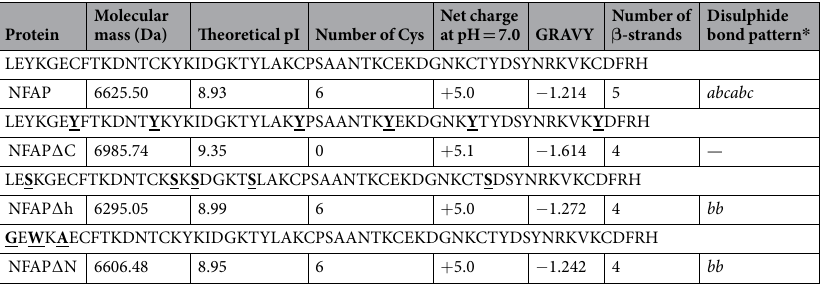
Table 1. Amino acid sequence and in silico predicted physical and chemical properties of the mature NFAP and its mutants. Substitutions in the amino acid sequences are indicated with bold and underlined letters. * The formation of disulphide bridges between C7-C35 and C27-C53 in NFAP ∆ h and NFAP ∆ N is impossible, as the distance between these cysteines is over the disulphide bonding limit, 2.3 Å 26 . GRAVY: grand average of hydropathy value; NFAP: Neosartorya fischeri NRRL 181 antifungal protein; NFAP ∆ C: cysteine deletion NFAP mutant; NFAP ∆ h: hydrophobic core deletion NFAP mutant; NFAP ∆ N: N-terminal amino acids exchanged NFAP